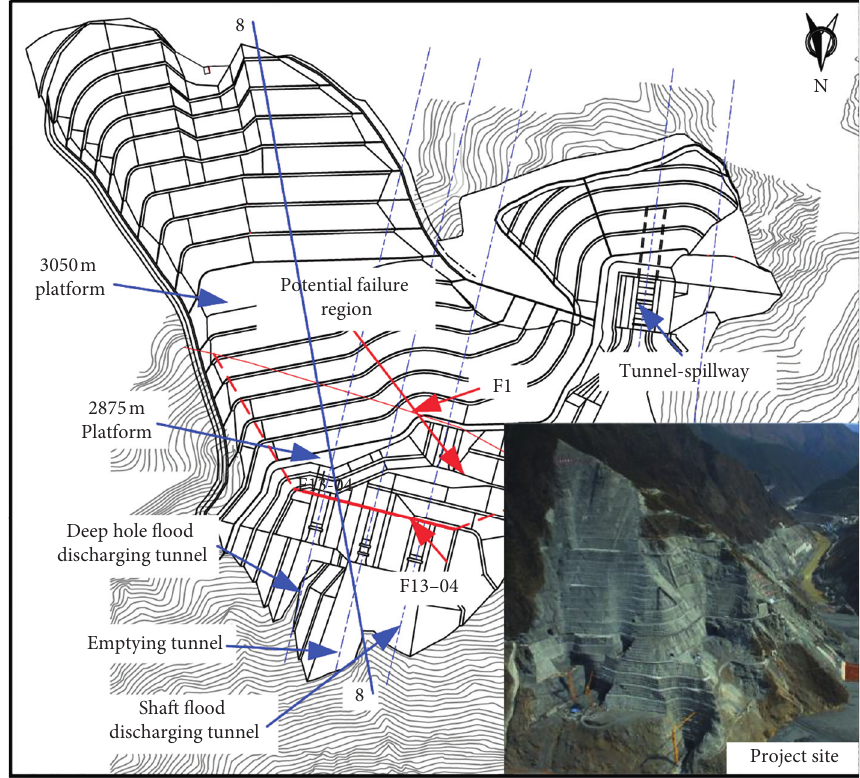
Figure 10: The layout of the inlet slope of outlet structures.